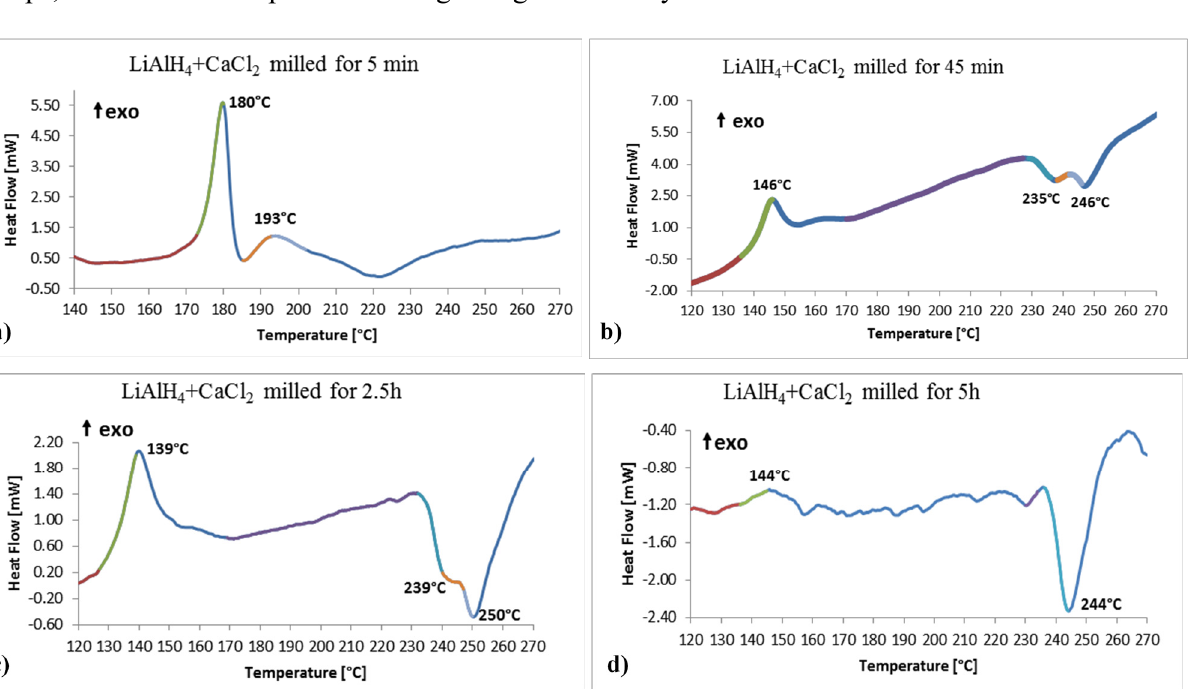
Figure 4. Selected DSC traces for the (2LiAlH 4 +CaCl 2 ) powders after varying milling durations. ( a ) 5 min; ( b ) 45 min; ( c ) 2.5 h and ( d ) 5 h. Heating rate 5